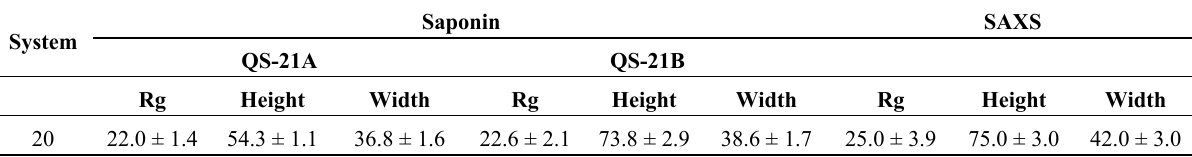
Table 2. Comparison between the dimensions (radius of gyration, height and width) obtained by MD simulations of (QS-21A) values are given in